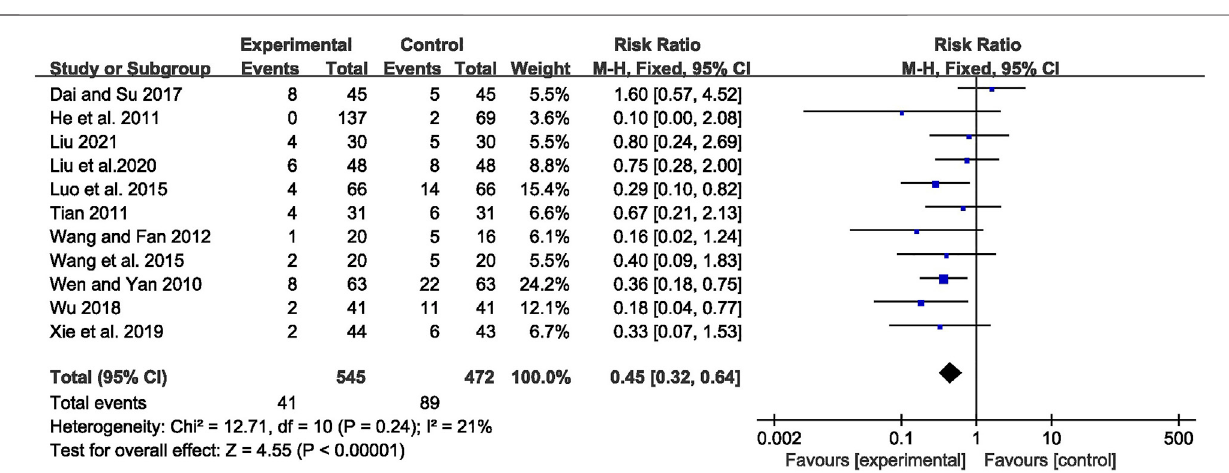
FIGURE 9 | Forest plot displaying the effects of CHM+AEDs vs. AEDs for adverse events in patients with IE.